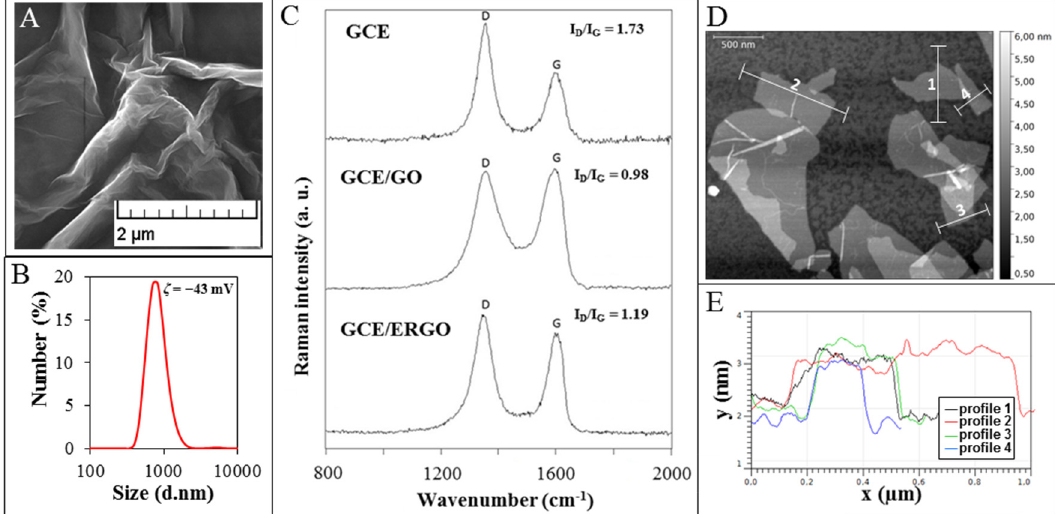
Figure 1. ( A ) Micrograph of GO used to modify GCE obtained by SEM; ( B ) GO size distribution including zetapotential; ( C ) Raman spectra of GCE, GCE modified with GO and GCE modified with ERGO; ( D ) AFM image of GO and ( E ) the height profiles along lines displayed in AFM image.